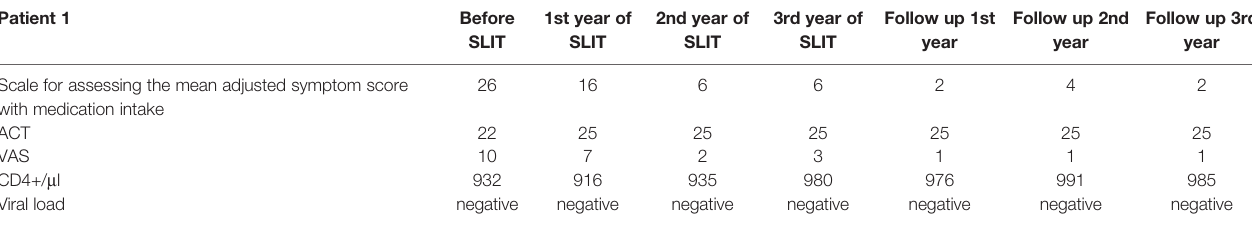
TABLE 1 | Development of CD4+ Cell Count, HIV RNA, questionary